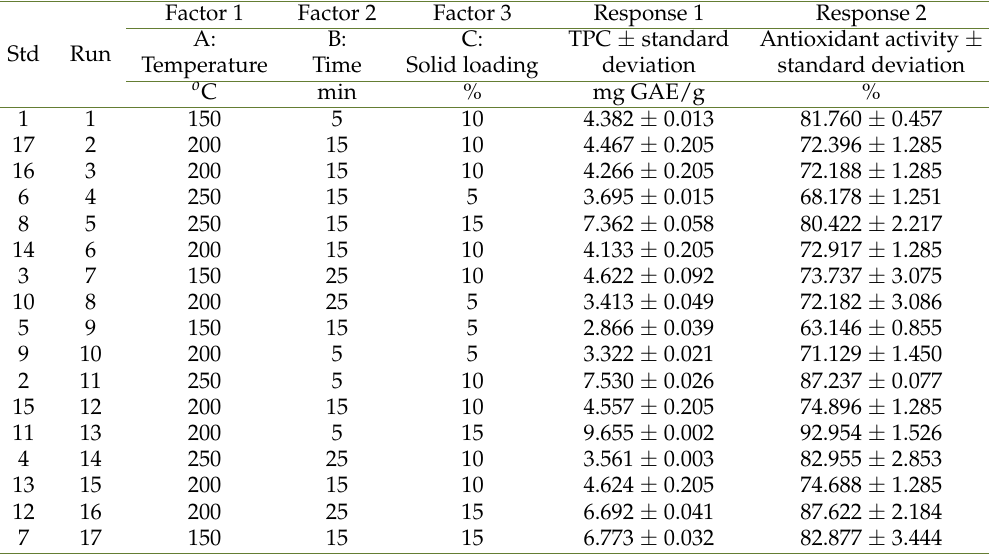
Table 1. Experimental data of the PBL leaves extracted using